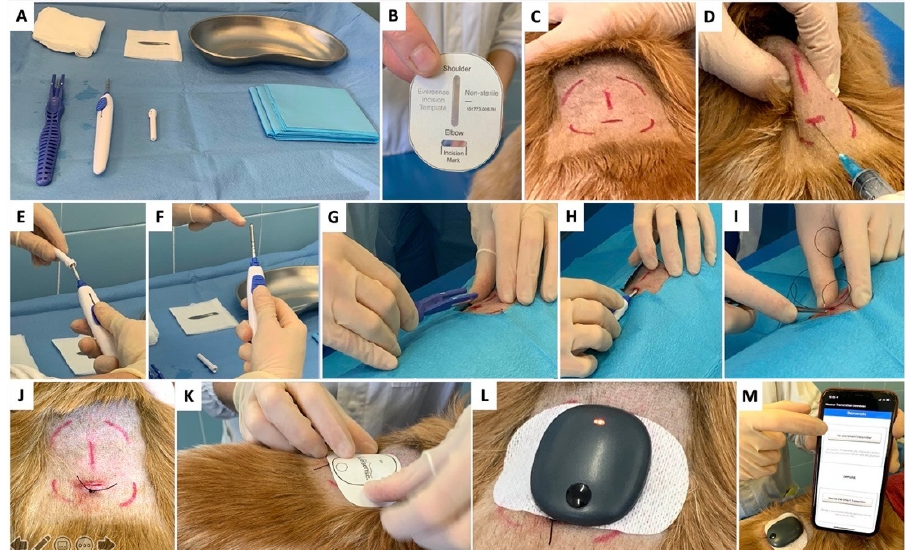
Figure 2. Eversense XL insertion in a diabetic dog. ( A ) Eversense XL sensor pack, blunt dissector and insertion tool with the necessary equipment: sterile cloth, gauze pads (3 with alcoholic chlorhexidine), and scalpel blade; ( B ) the incision template which is used to guide and mark the incision area on the skin surface by aligning the marking template to the marked outer edges of the smart transmitter; ( C ) the skin is trichotomized, marked using the incision template, and cleaned with chlorhexidine ( D ) local anesthesia (lidocaine) is injected along the planned incision site; ( E ) the sensor holder is slid into the insertion tool; ( F ) the sensor is secured inside the insertion tool; ( G ) Once the insertion area is sufficiently anesthetized, a small incision of 5–8 mm is made and, a subcutaneous pocket is created to accommodate the sensor using the blunt dissector. ( H ) the sensor is placed in the subcutaneous pocket making use of the insertion tool; ( I ) the skin is closed with non-absorbable sutures; ( J ) the sensor is now in place and ready for connection with the smart transmitter; ( K ) an adhesive patch, which attaches to the skin and to the back of the smart transmitter, is applied over the insertion site; ( L ) the smart transmitter is placed over the adhesive patch (the transmitter and adhesive patch are removed every 24 to 72 h in order to recharge the battery); ( M ) The smart transmitter is paired with the mobile device and linked to the sensor.